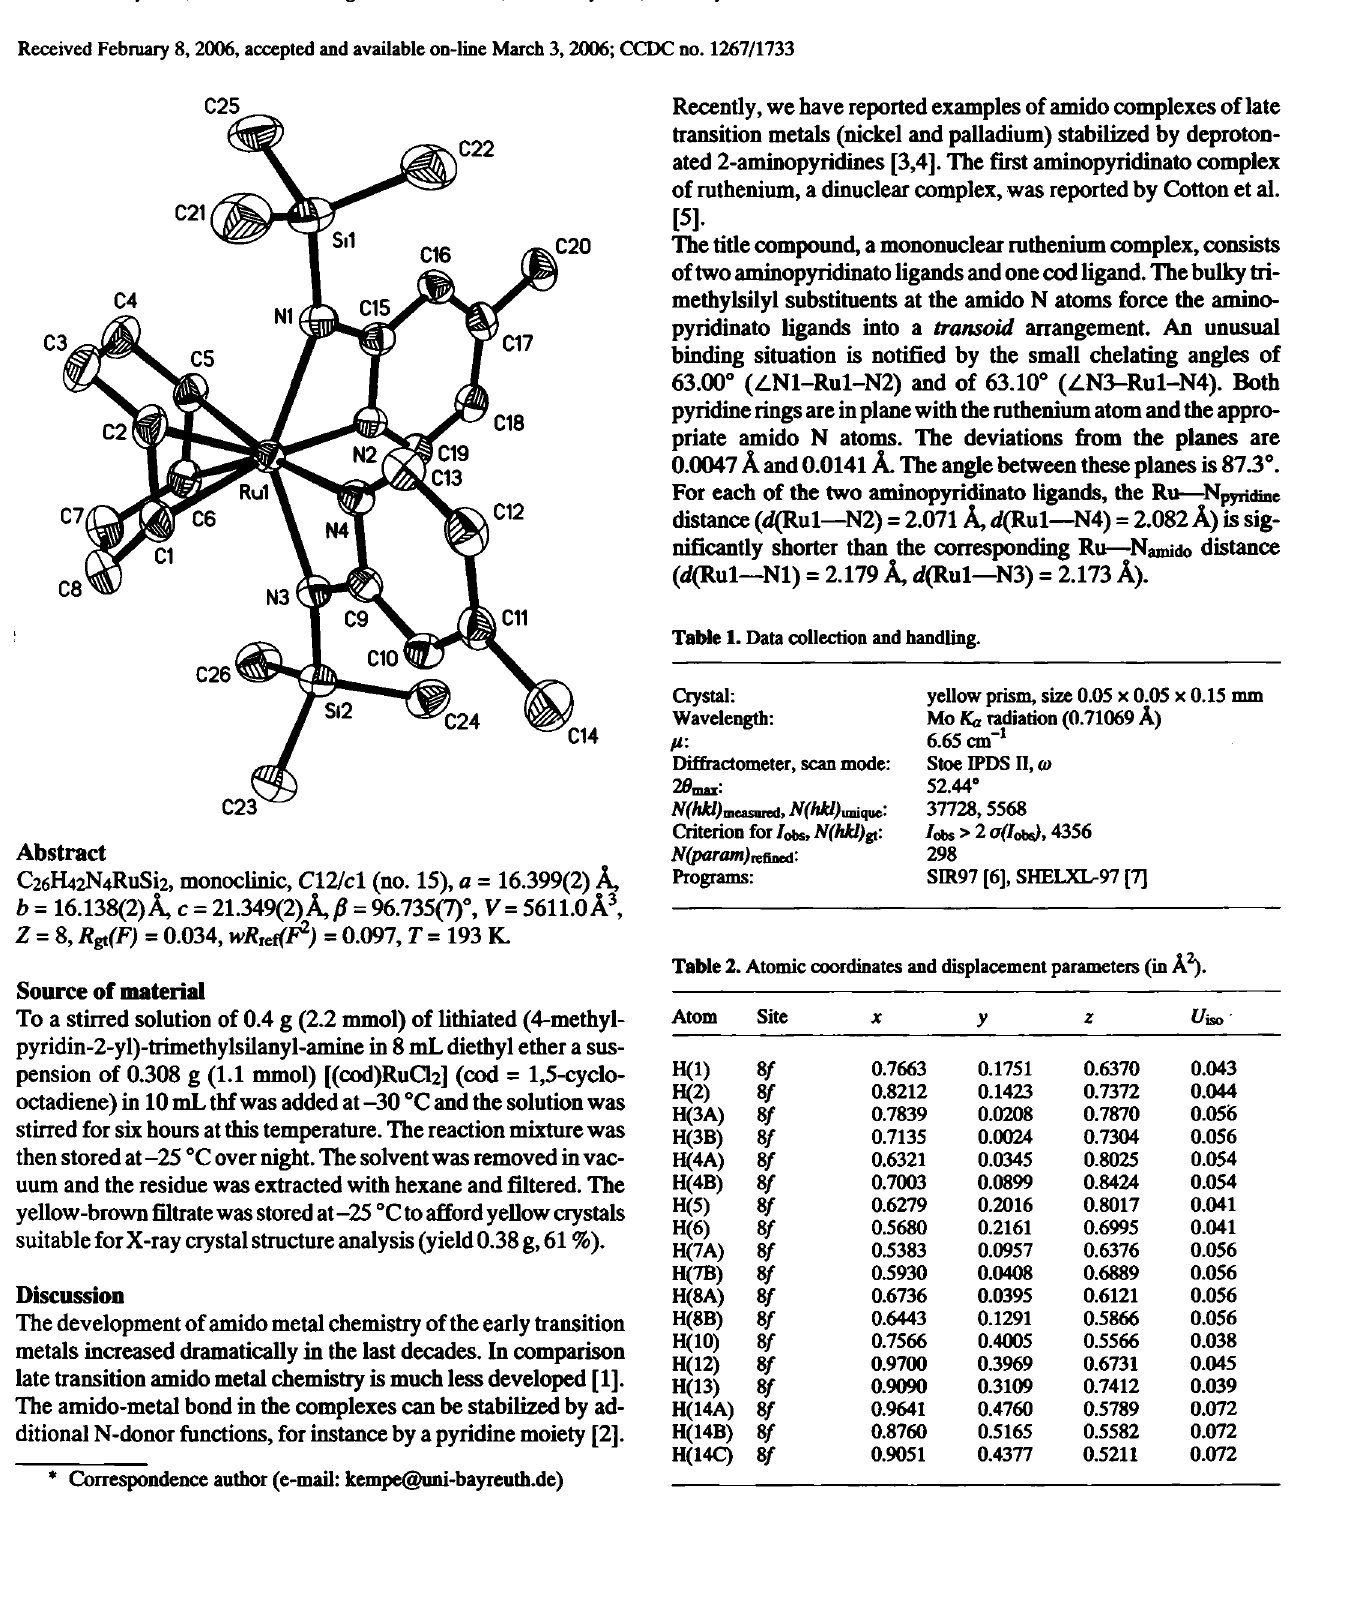
Table 2. Atomic coordinates and displacement parameters (in Ä 2